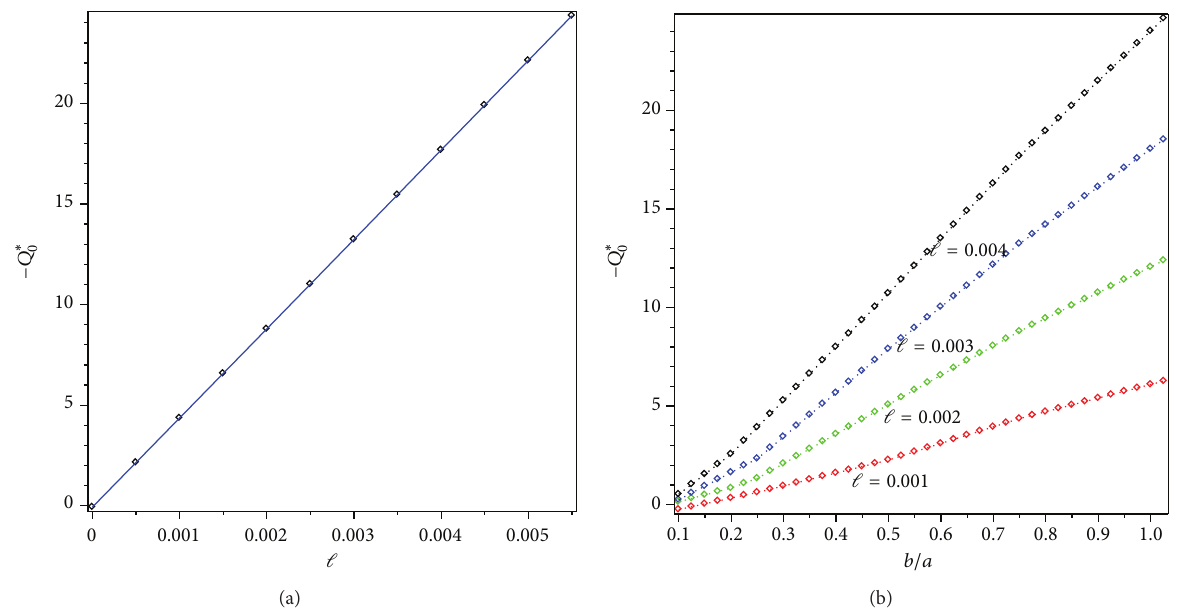
Figure 5: Influence of slip length and the ratio 𝜀 on the flow rate 𝑄 ∗ 0 on the cross-section of the channel with the constant area of 1.0×10 −6 m 2 for a constant gradient